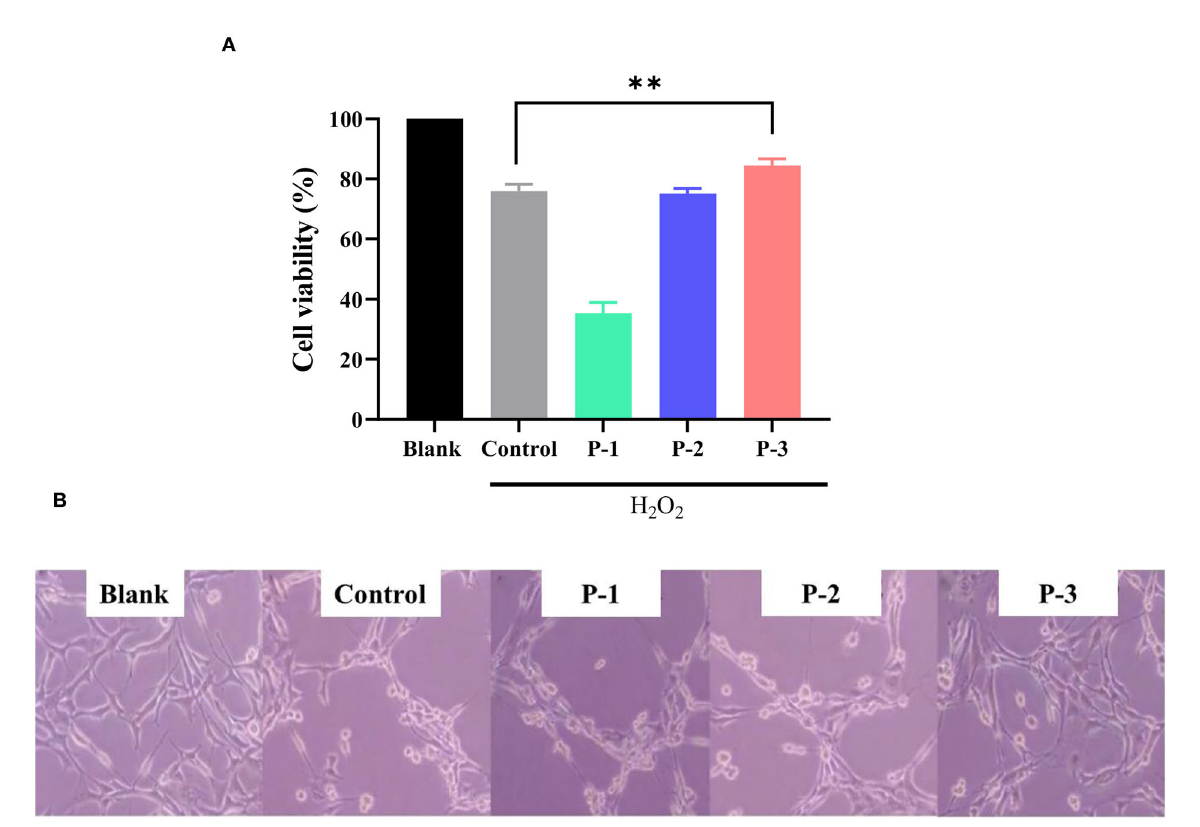
FIGURE3 (A) Cell viability of the 1.4mM H 2 O 2 -induced HSF cells after treatment with 0.6 mg/ml of P-1, P-2, and P-3 for 24h. The data were reported as percent viability compared to the control. (B) Morphological observation of H 2 O 2 -induced HSF cells after treatment with 0.6 mg/ml P-1,